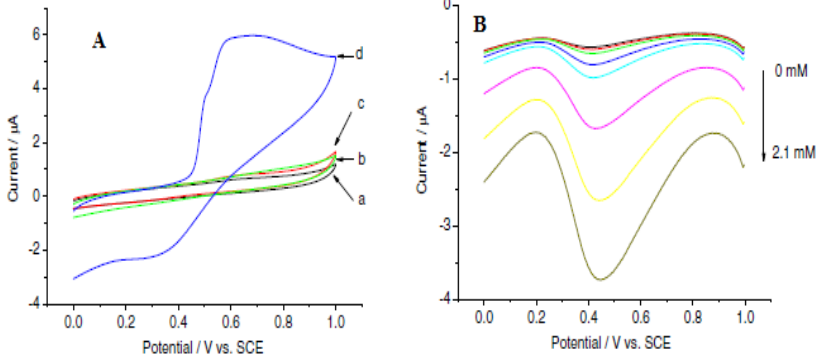
Figure 8. ( A ) Cyclic voltammograms of ChOx/Chit/GCE (curves ( a , b )) and ChOx/MnO 2 /Chit/GCE (curves ( c , d )) in the absence (curves ( a , c )) and presence of 0.30 mM (curves ( b , d )) choline chloride in 0.2 M borate buffer solution (BPS), pH 7.8, at 100 mV s − 1 scan rate. ( B ) Square-wave voltammograms of ChOx/MnO 2 /Chit/GCE in the aforementioned buffer at different concentrations of choline chloride (0, 0.02, 0.1, 0.2, 0.3, 0.7, 1.3 and 2.1 mM) from the top down. Reprinted with permission from [43]. Copyright (2007) Elsevier.